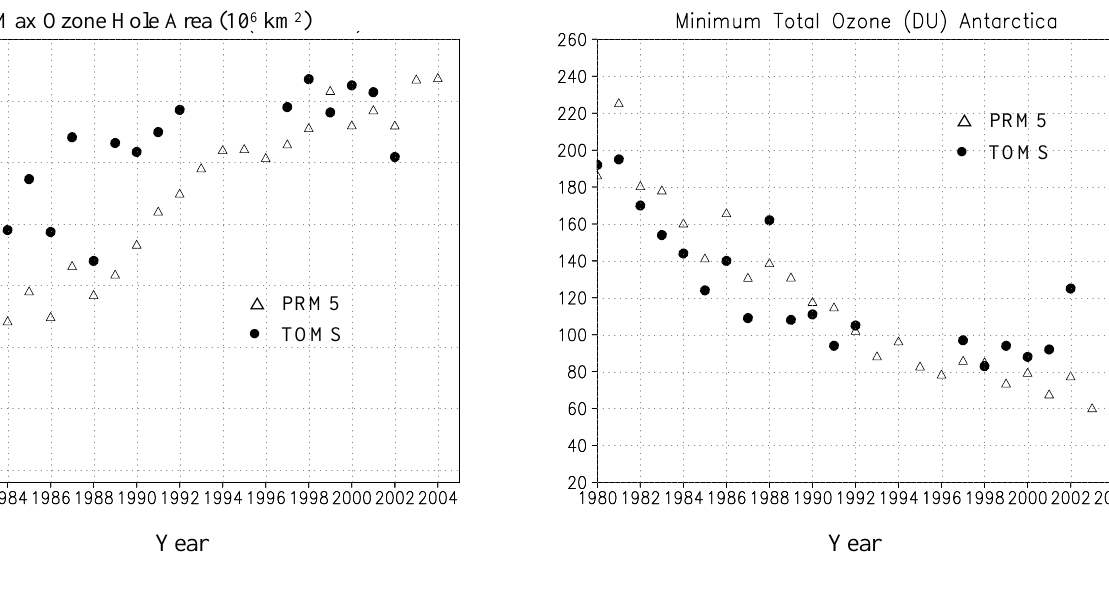
Fig. 7. Evolutions of the annual maximum area of the Antarctic ozone hole ( < 220DU) in units of 10 6 km 2 (left) and the annual minimum of total ozone in DU (right). Triangles represent simulated data, and filled circles represent observed data (TOMS/SBUV).